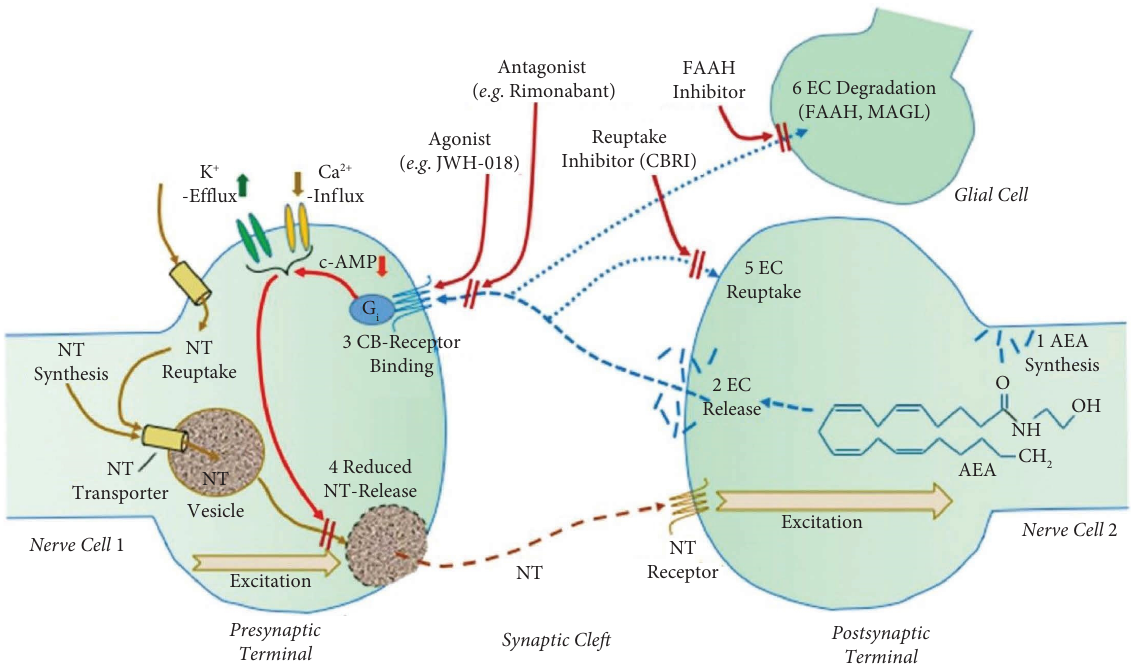
Figure 2: Drug interactions (red) and endocannabinoid pathways (blue) in the synapse. Endocannabinoids (e.g . , arachidonolyethanolamine (AEA)) is formed in the membrane phospholipids’ postsynaptic terminal and the “retrograde” released into the synaptic cleft (adapted from